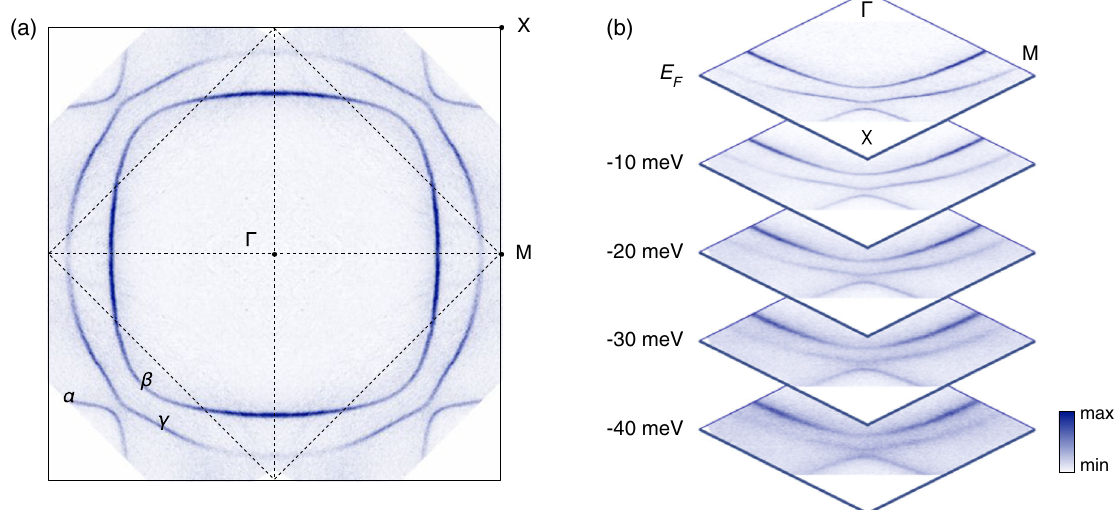
FIG. 1. (a) Fermi surface of Sr 2 RuO 4 . The data were acquired at 5 K on a CO passivated surface with a photon energy of 11 eVand p polarization for measurements along the Γ X symmetry line. The sample tilt around the Γ X axis used to measure the full Fermi surface results in a mixed polarization for data away from this symmetry axis. The Brillouin zone of the reconstructed surface layer is indicated by diagonal dashed lines. Surface states and final-state umklapp processes are suppressed to near the detection limit. A comparison with ARPES data from a pristine cleave is shown in the Appendix A. The data in panel (a) have been mirror symmetrized for clarity. Original measured data span slightly more than a quadrant of the Brillouin zone. (b) Constant energy surfaces illustrating the progressive broadening of the quasiparticle states away from the Fermi level E F